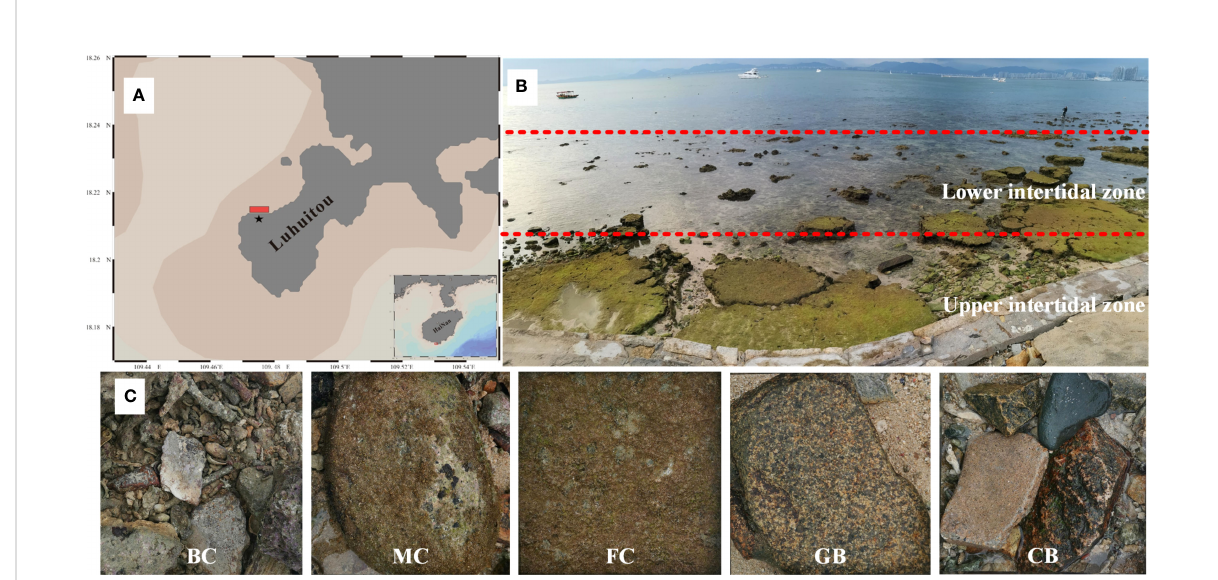
FIGURE 1 Study sites on Hainan Island. (A) Location of the Luhuitou fringing reef; (B) diagram of the study area; (C) representative photograph of the fi ve types of substrate (dead branching coral [BC], dead massive coral [MC], dead fl at coral [FC], granite [GB], and concrete block